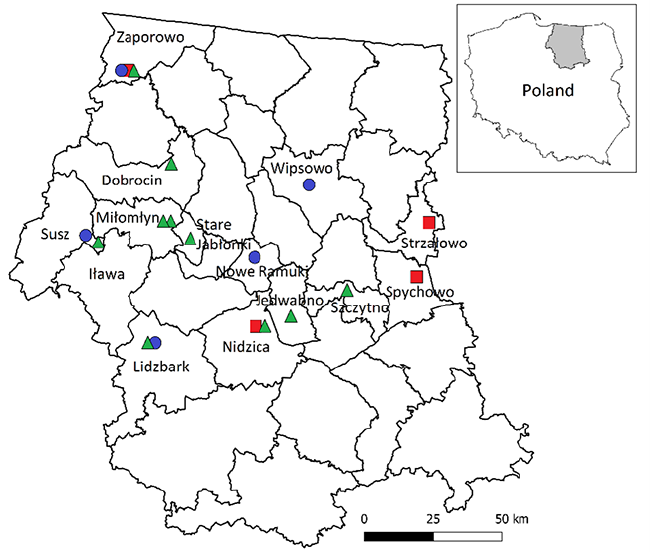
Figure 2 Locations of the assessed tree clusters in the Warmia region (Olsztyn Forest Directorate): green triangle – Pseudotsuga menziesii ; blue circle – Pinus strobus ; red square – Thuja plicata